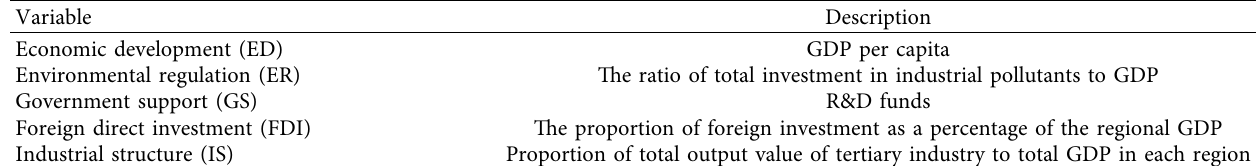
Table 2: The influencing factors of green innovation efficiency in YREB.